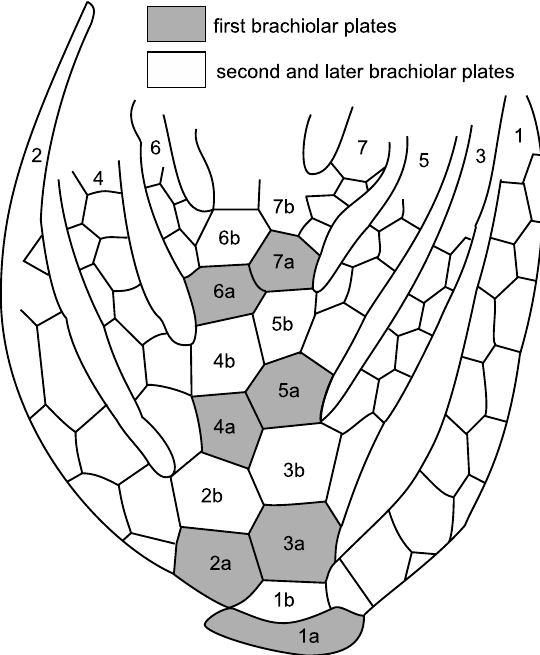
Fig. 7. Structure of the erect ambulacra of the coronate Stephanocrinus angu latus Conrad, 1842, Wenlock (Silurian), New York, USA. Biserial brachioles (1–7) are numbered in order of formation and the first two plates (1a, 1b, and so on) are modified to form the main ambulacral trunk. Note that because this is an aboral view, brachiole 1 is anatomically left but on the right of the figure. Redrawn from Brett et al. 1983: 640, fig.